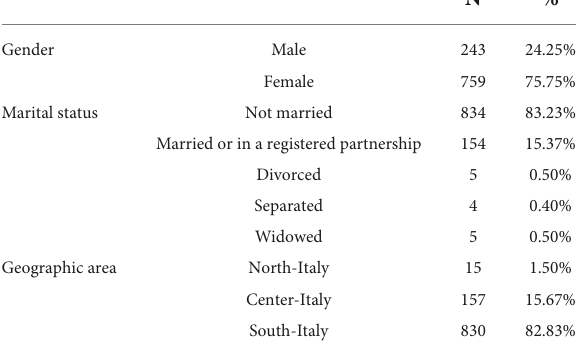
TABLE 1 Descriptive statistics of the